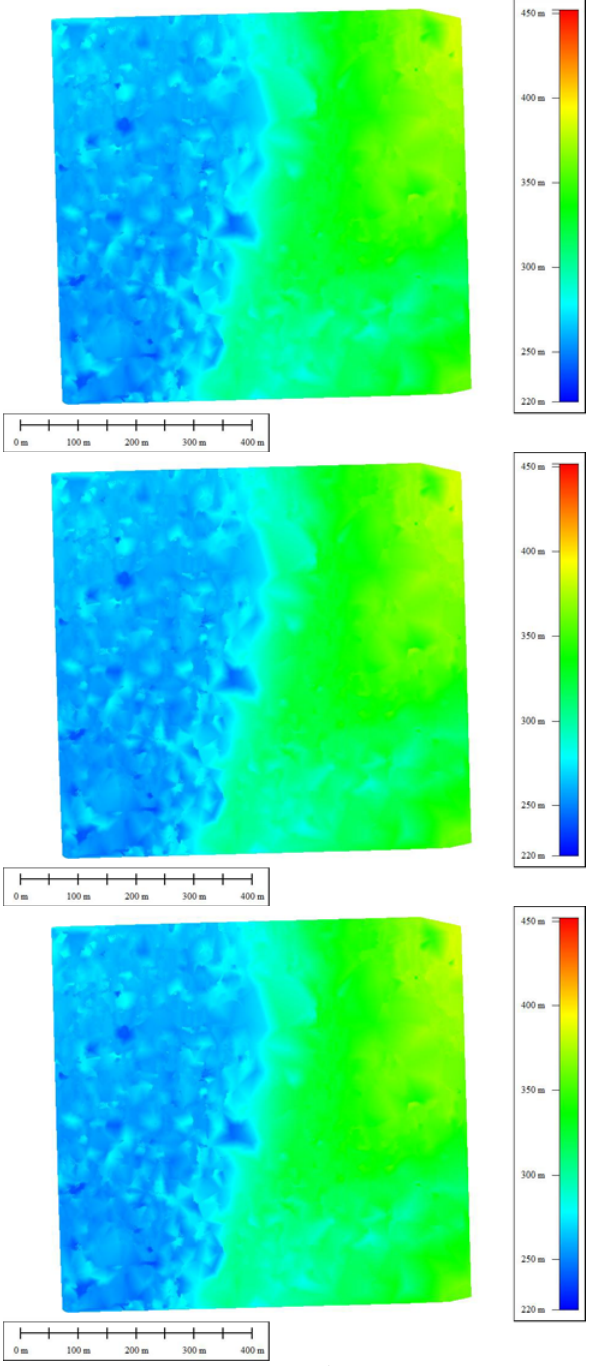
Figure 2. Radargrammetric DSM of Trento – Tile 2, descending (above), ascending (centre), merged (below) These results are representative of the potentialities of the radargrammetric model, anyway the achievable accuracy is strictly related to the terrain